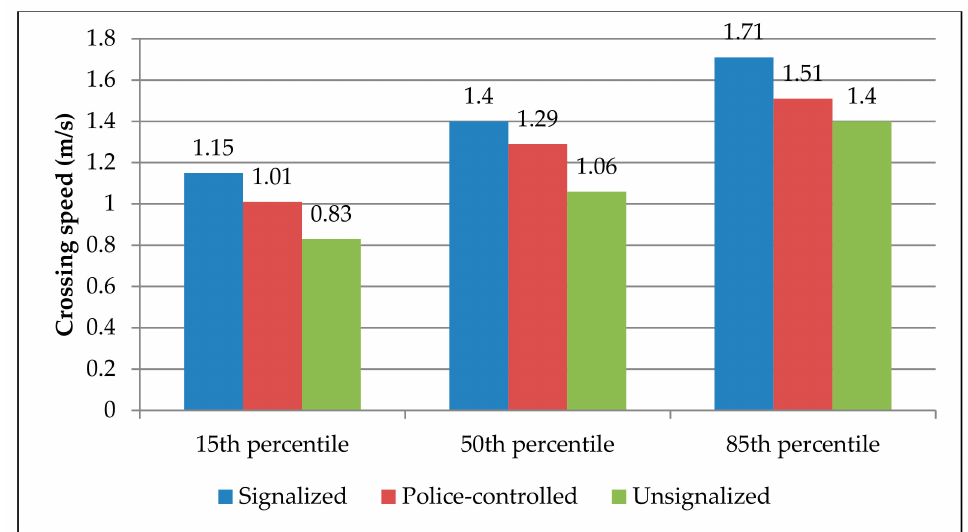
Figure 1. Pedestrian crossing speed by intersection control